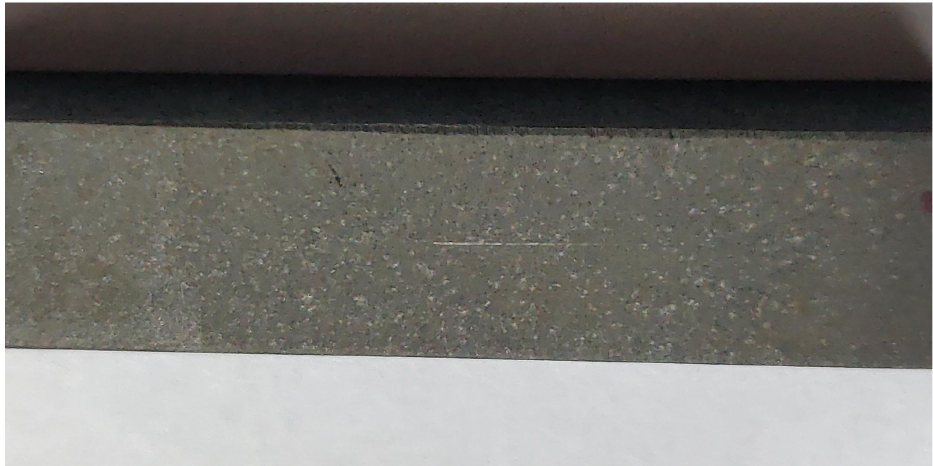
Figure 13. Photograph of the phosphate nodular cast iron specimen after the scratch test.